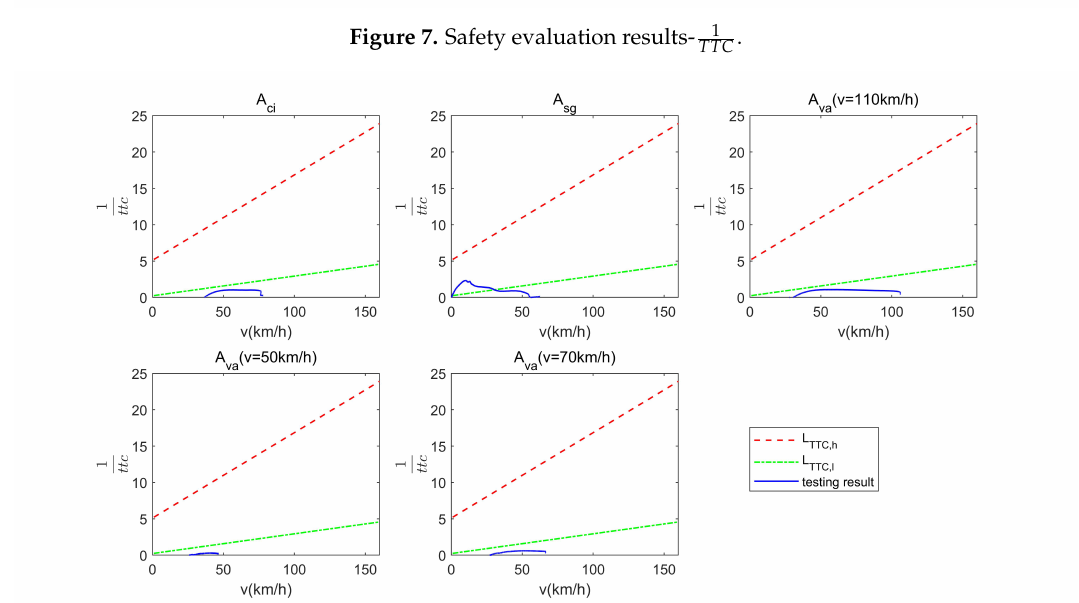
Figure 7. Safety evaluation results- 1